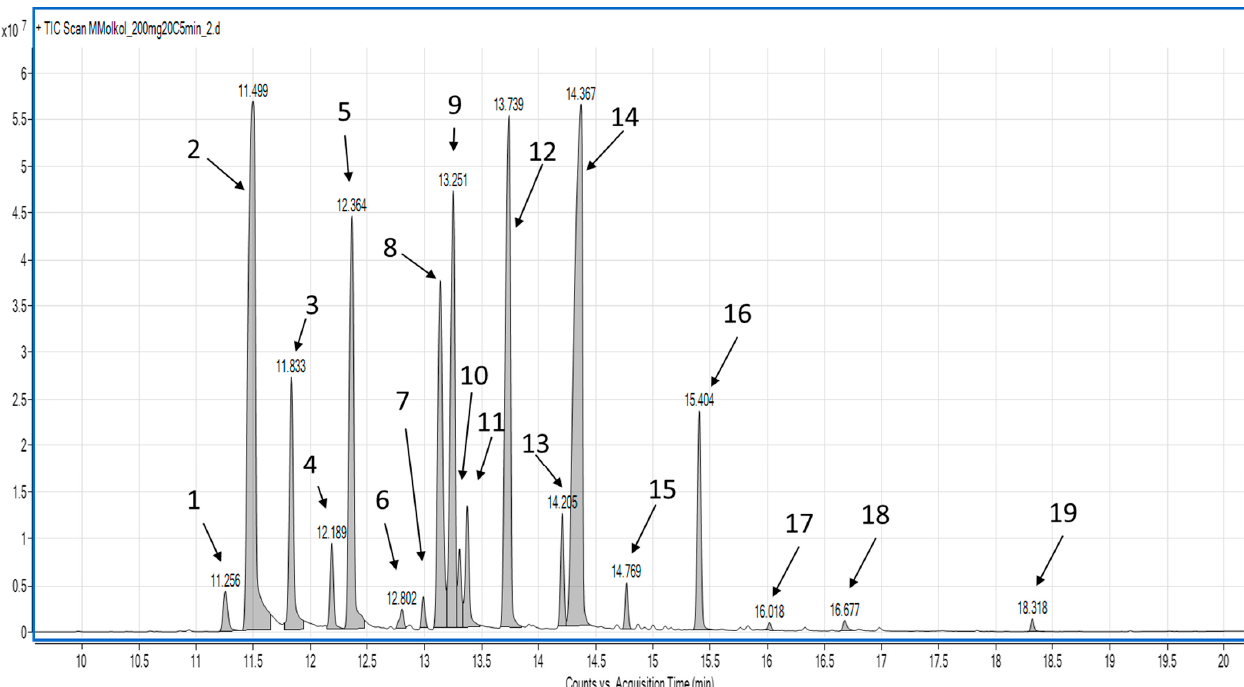
Figure 1. TIC chromatogram of main volatile terpenes obtained using vacuum-assisted sorbent extraction (VASE) at 20 °C. (1) α -thujene; (2) α -pinene; (3) camphene; (4) sabinene; (5) β -pinene; (6) α -phellandrene; (7) α -terpinene; (8) o-cymene; (9) sylvestrene; (10) unknown; (11) cis-ocimene; (12) γ -terpinene; (13) terpinolene; (14) β -linalool; (15) allo-ocimene; (16) camphor; (17) unknown; (18) geraniol; (19) geranyl acetate.